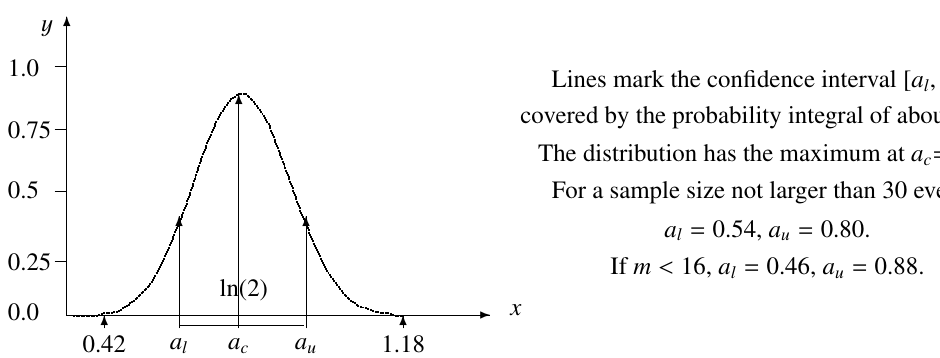
Figure 1. The distribution of M m (expo case). The values along the x -abscissa denote ratios of the sample median to the sample mean; the values along the y -ordinates denote the probabilities of these ratios.